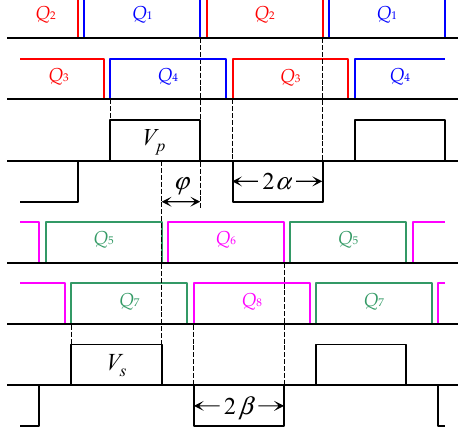
Figure 2 shows the eight switches control signals of the dual active bridges. S 1 ~ S 4 , S 5 ~ S 8 are the primary side and secondary side control signals, respectively. V p and V s are output three-level square wave voltage signals of the primary side and secondary side.